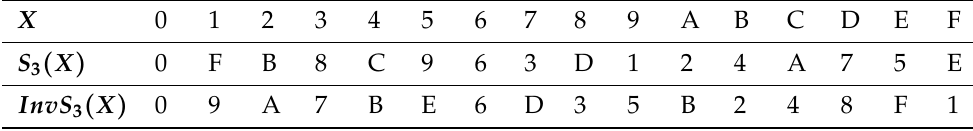
Table 4. Fourth S-Box of Serpent defined as S 3 ( X ) .